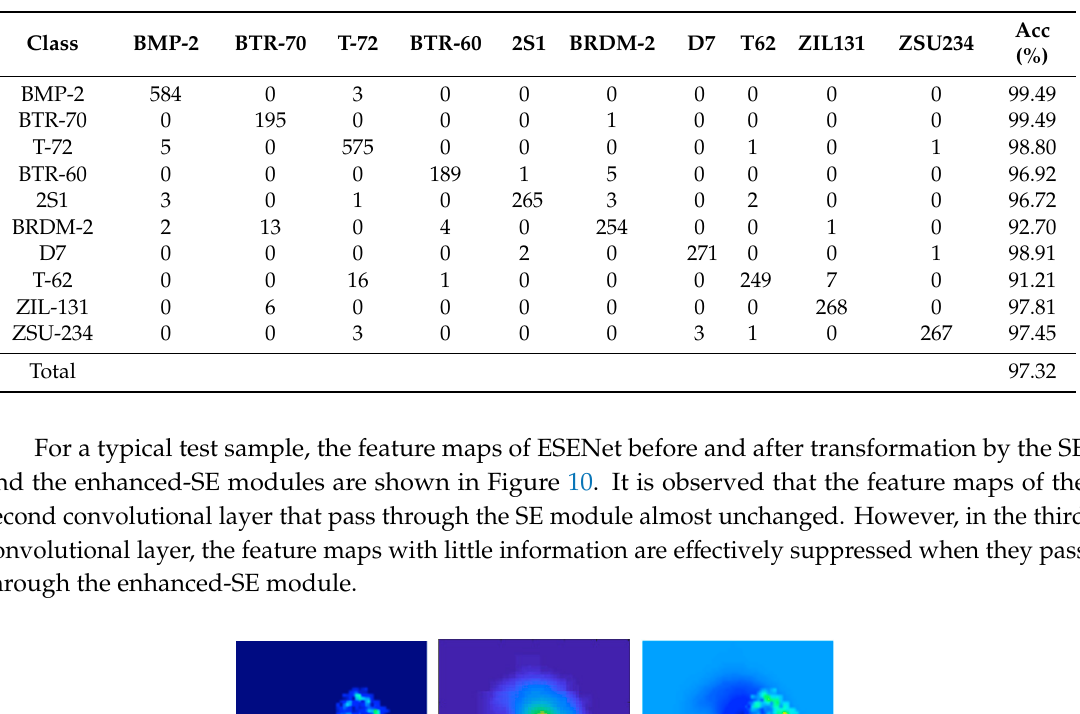
( f ) Figure 11. Feature maps of conv3 in SENet and ESENet. ( a ) input image; ( b ) input image with the mean of training samples removed; ( c ) feature maps of conv3 in the SENet; ( d ) feature maps of conv3 in the SENet after passing through the SE module; ( e ) feature maps of conv3 in the ESENet; and, ( f ) feature maps of conv3 in the ESENet after passing through the enhanced-SE module. 4.5. Results of EOC1 Subsequently, the EOC1 dataset is utilized to evaluate the performance of ESENet under large depression angle variation. As shown in Table 7, the recognition accuracy of traditional CNN, the A-convnet, the SENet, and the ESENet is 88.44%, 89.05%, 90.27%, and 93.40% respectively, which shows that the ESENet outperforms the others under EOC1. However, the accuracy of the EOC1 experiment is lower than that of the SOC experiment. As expected, the large difference between the training and the test samples decreases the recognition accuracy, because the SAR image is sensitive to the variation of viewing angles.